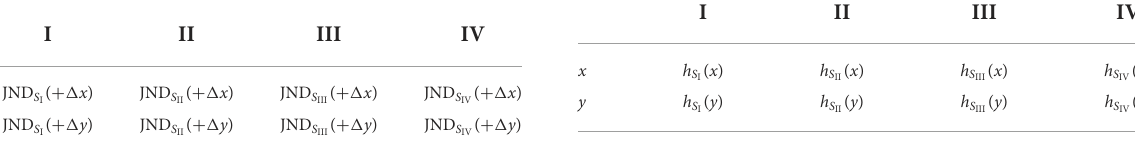
TABLE 2 The perceptual resolution of each dimension in each quadrant.